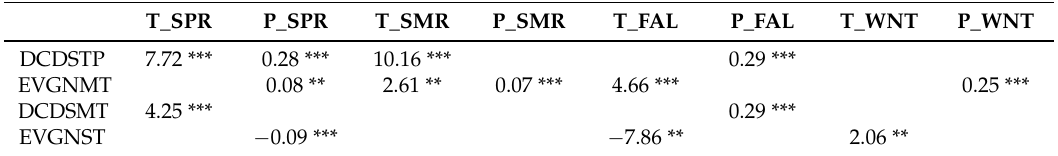
Table 5. Regressed coefficients of the growing season length on seasonal precipitation (P, day·mm − 1 ) and mean temperature (T, day·°C − 1 ). SPR, SMR, FAL, and WNT indicate spring, summer, fall, and winter, respectively. P values were based on one-tailed hypothesis, and “**” and “***” are for p -values less than 0.05 and 0.01, respectively.